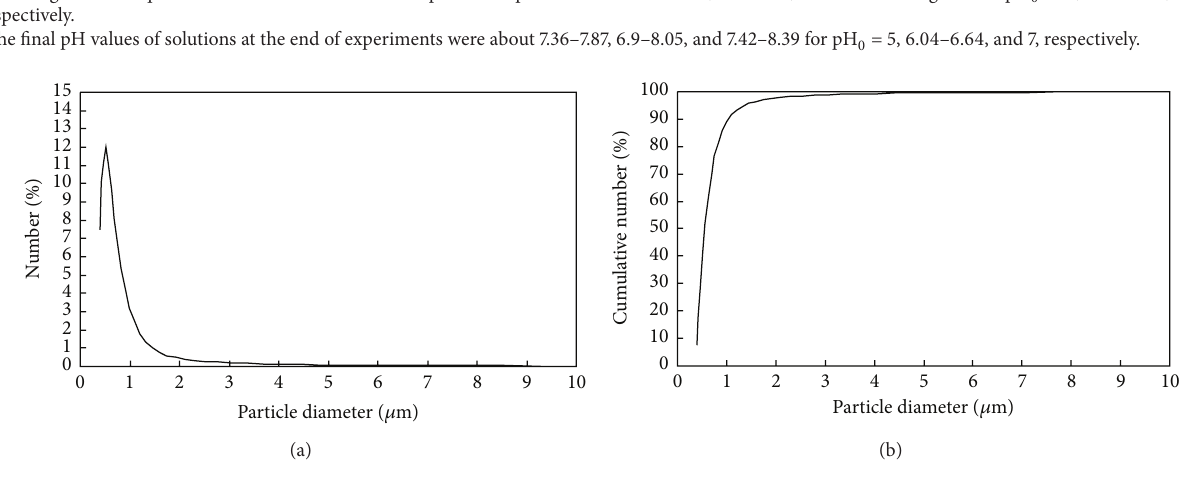
Figure 3: The relationship between (a) differential number % of M-PVAL and 𝑑 𝑃 and (b) cumulative number % and 𝑑 𝑃 .